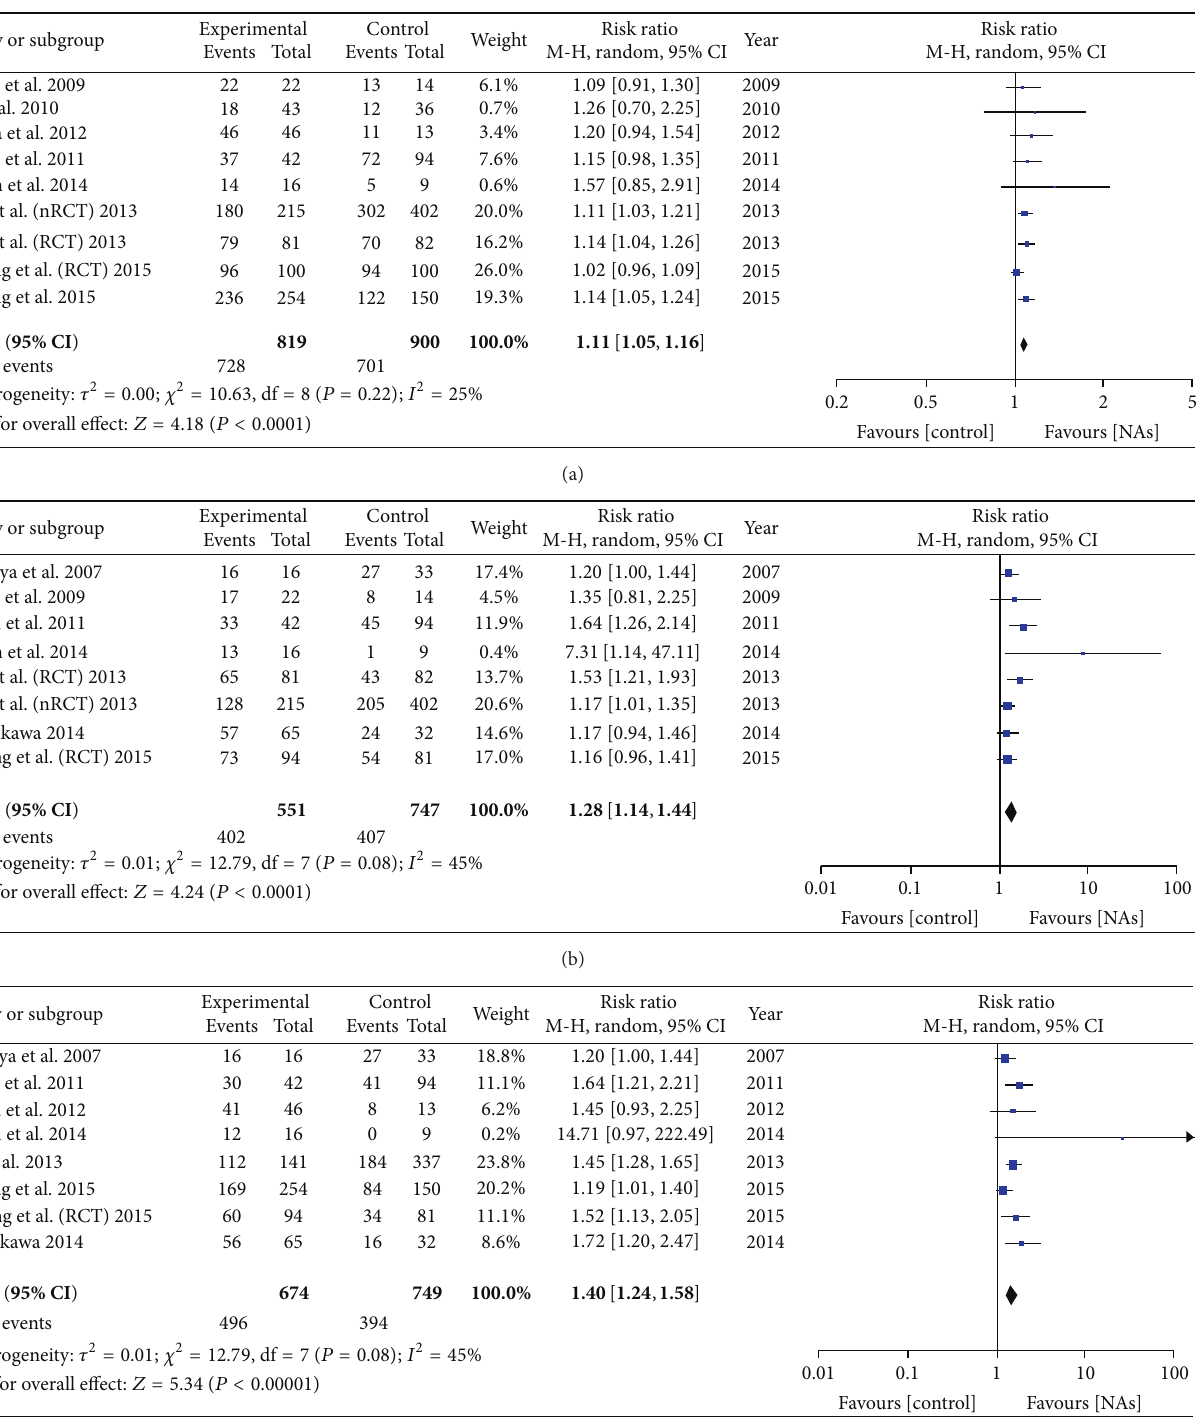
Figure 3: (a) Forest plot showing the impact of NAs on the 1-year OS. (b) Forest plot showing the impact of NAs on the 3-year OS. (c) Forest plot showing the impact of NAs on the 5-year